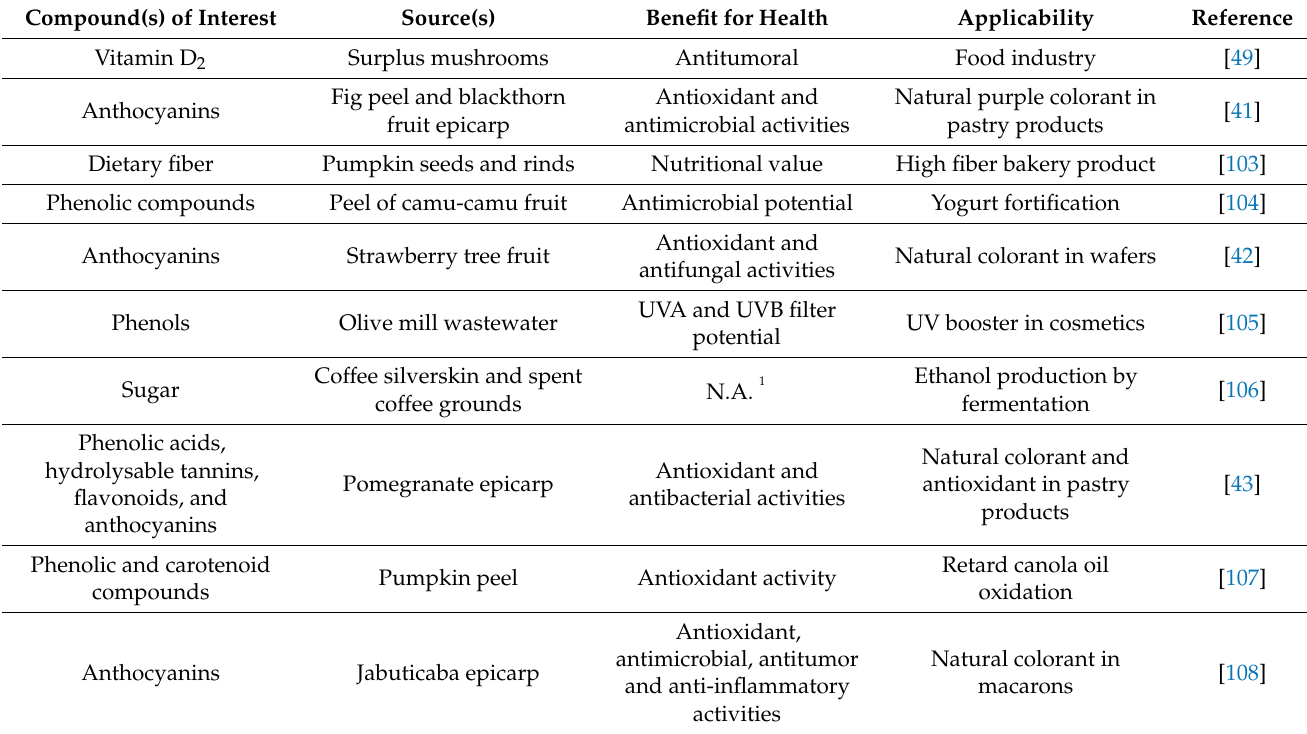
Table 3. Value-added compounds recovery from food waste and its